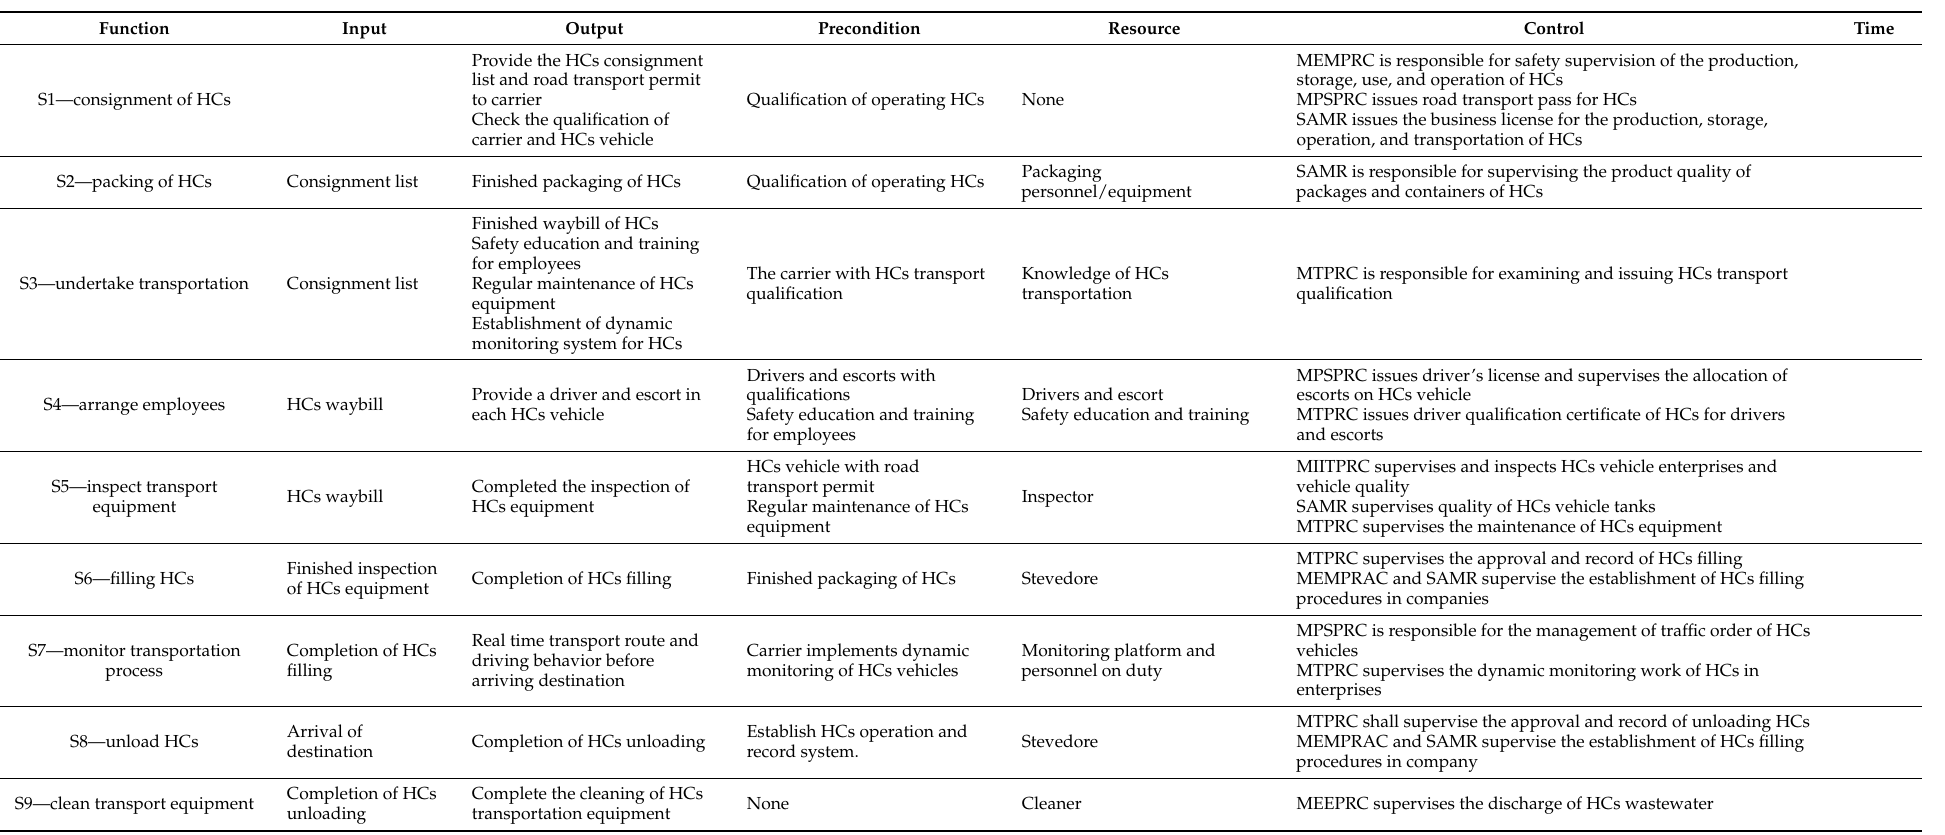
Table A1. The six aspects of